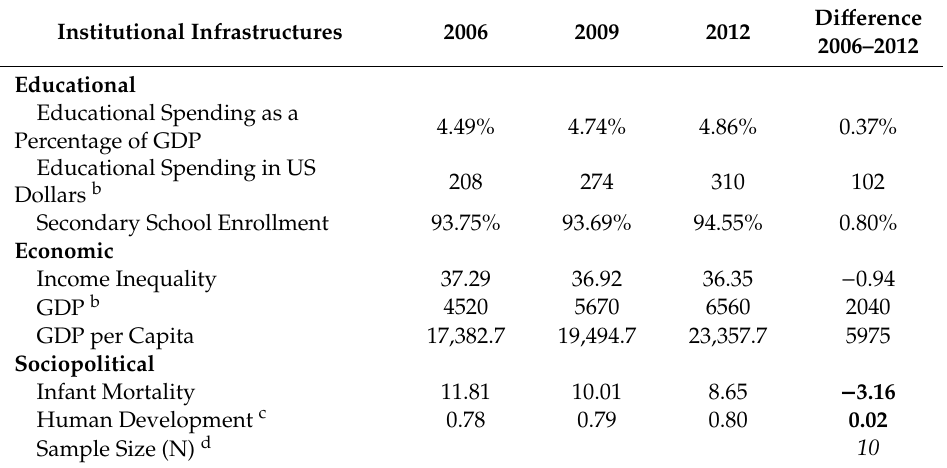
Table 5. Country-level institutional infrastructures of SI countries, 2006–2012 a